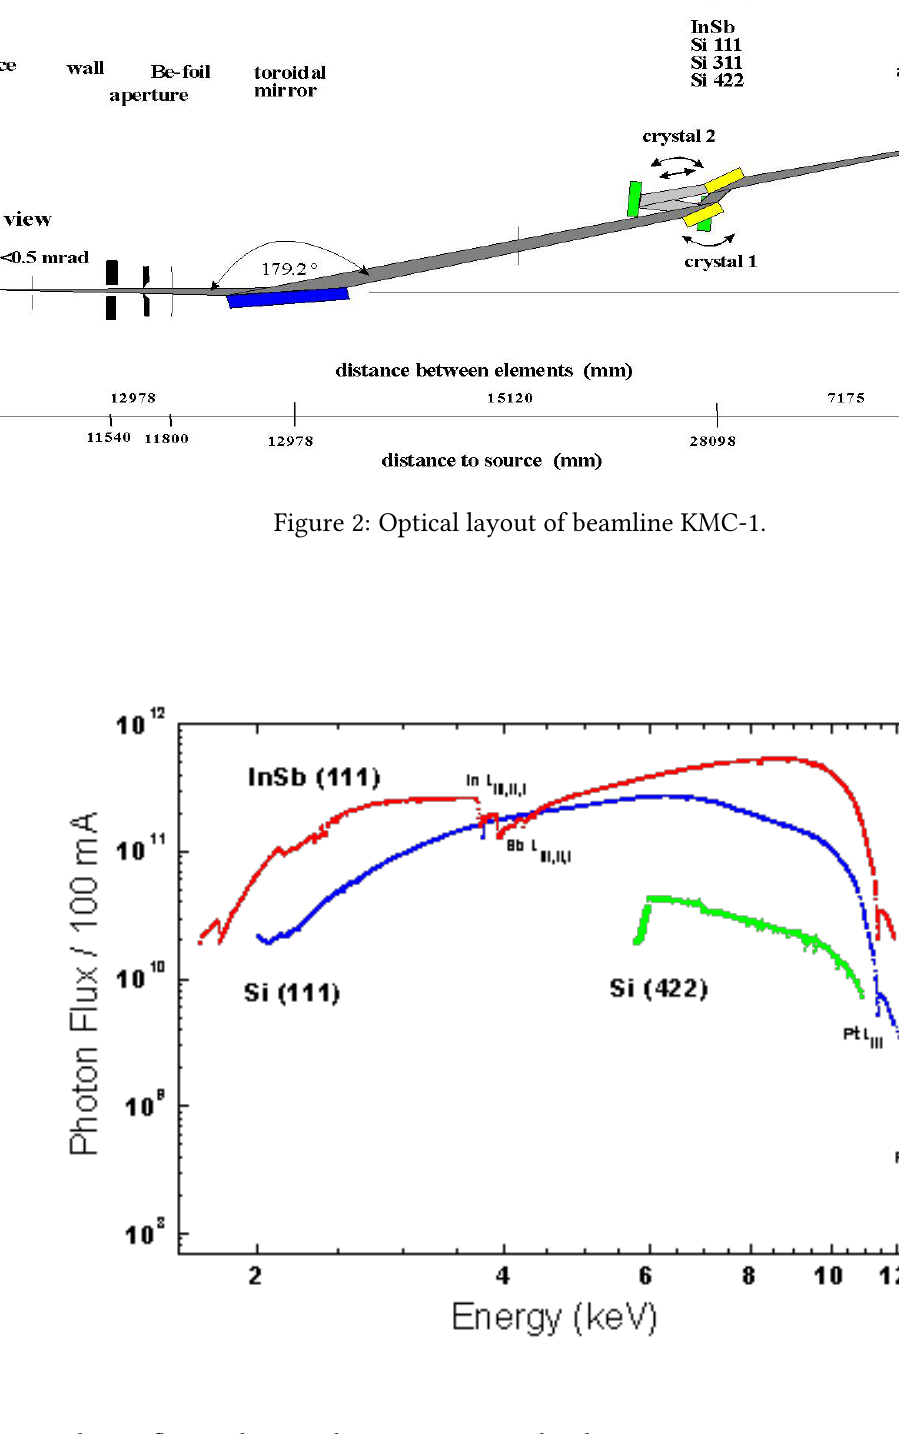
Figure 3: Photon flux at the sample position, normalized to 100 mA ring current. Typically BESSY-II runs with 300